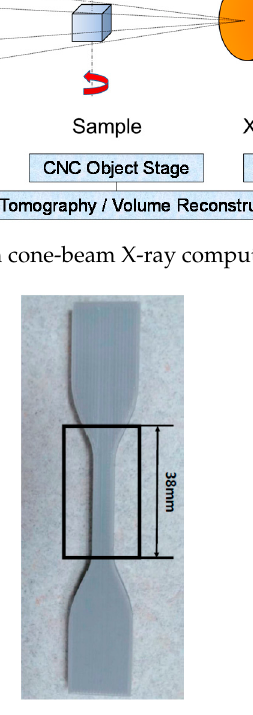
Figure 3. An illustration of the scanned area for XCT analysis in the PLA specimens .